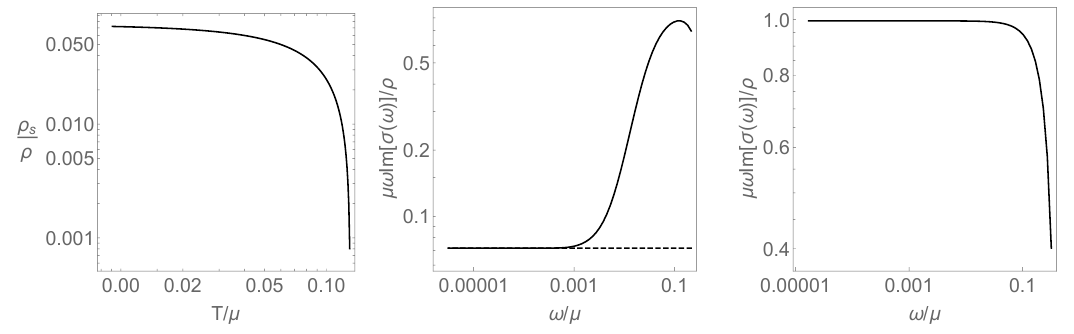
Figure 10 . Complete depletion of spectral weight in the T = 0 AdS-RN conductivity from trans- lation breaking. (Left) Weight of the T = 0 imaginary pole with m/µ = 1 / depletion of spectral weight. (Right) Weight of the T = 0 imaginary pole with m = 0 showing no depletion of spectral weight.